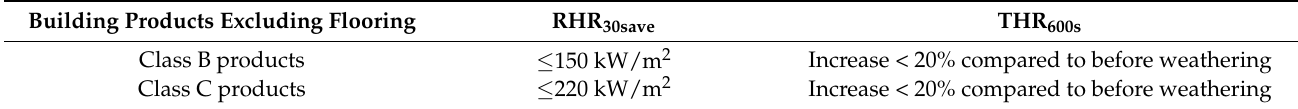
Table 4. Requirements for fire performance in durability according to ETAG 028 (2012). Heat flux: 50 kW/m 2 . Building Products Excluding Flooring